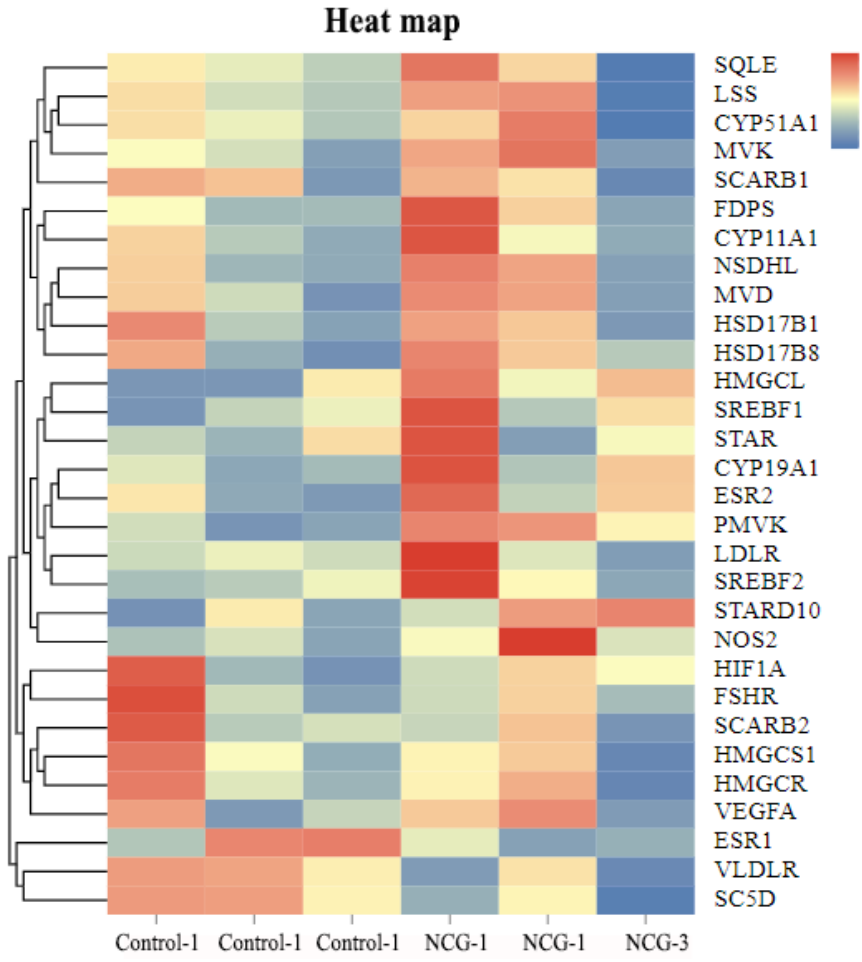
Figure 4. The expression profiles of genes related to steroid hormone metabolism, cholesterol synthesis, and angiogenesis as measured by RNA-Seq and represented in a heat map. The differences in gene expression levels are expressed in different colours, as illustrated in the legend.